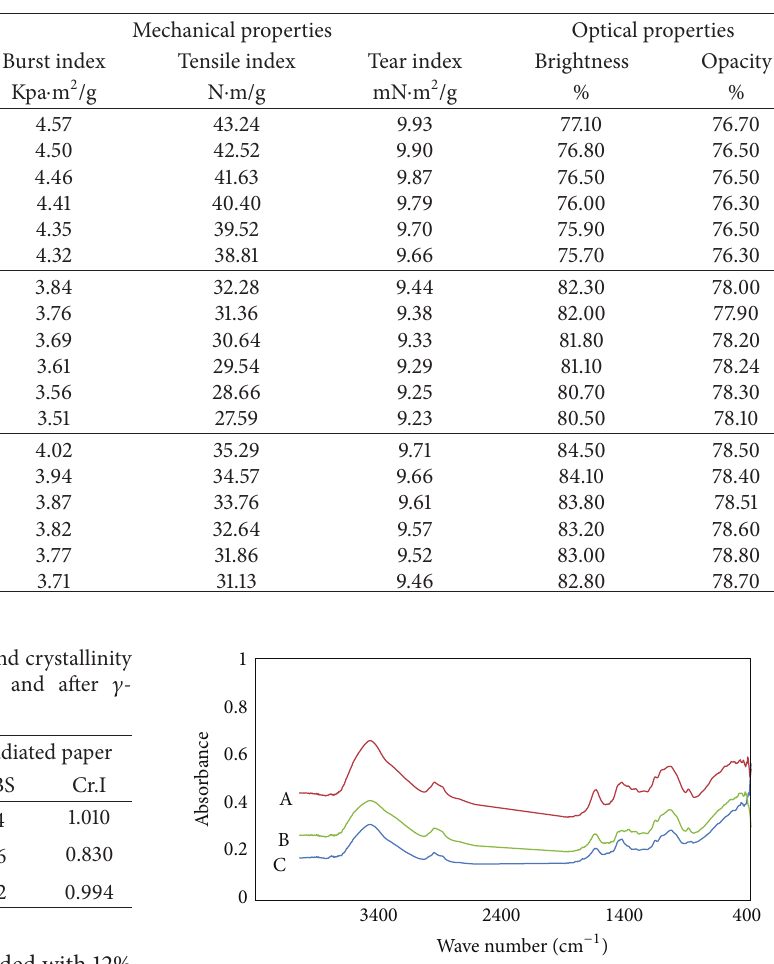
Figure 4: FTIR spectra for three nonirradiated wood paper hand- sheets. A: paper loaded with 12% kaolin, B: paper loaded with 12% Cs-kaolin, and C: paper without